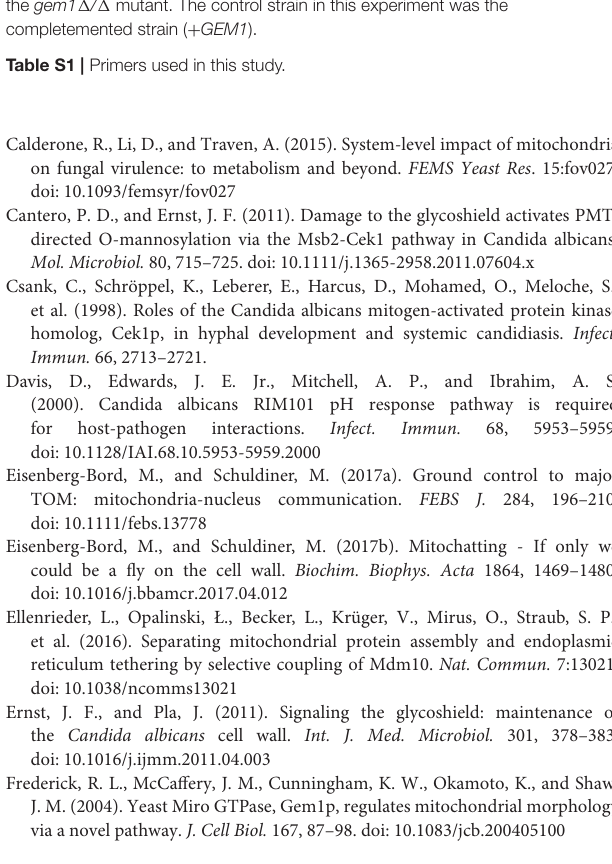
Figure S1 | Protein alignment of C. albicans Gem1, the human ortholog MIRO1 (hMIRO1) and human MIRO2 (performed with MUSCLE MUltiple Sequence Comparison by Log-Expectation v3.8.31). Figure S2 | Total cellular phospholipids were extracted from the indicated strains and separated by thin layer chromatography (TLC). Standards were used to